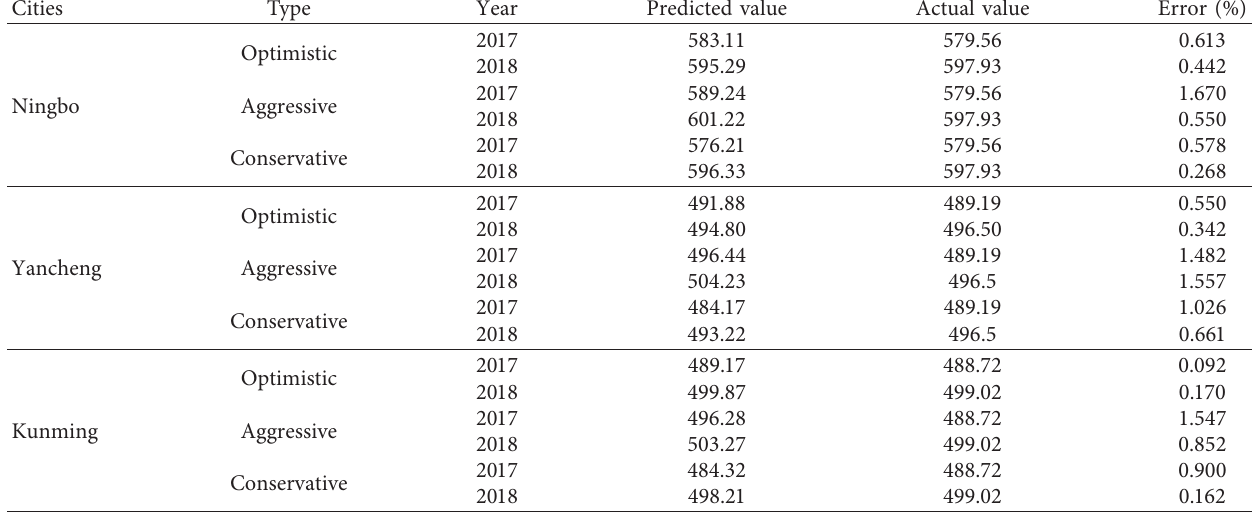
Table 10: Comparison of the predicted and actual UD values (unit (10